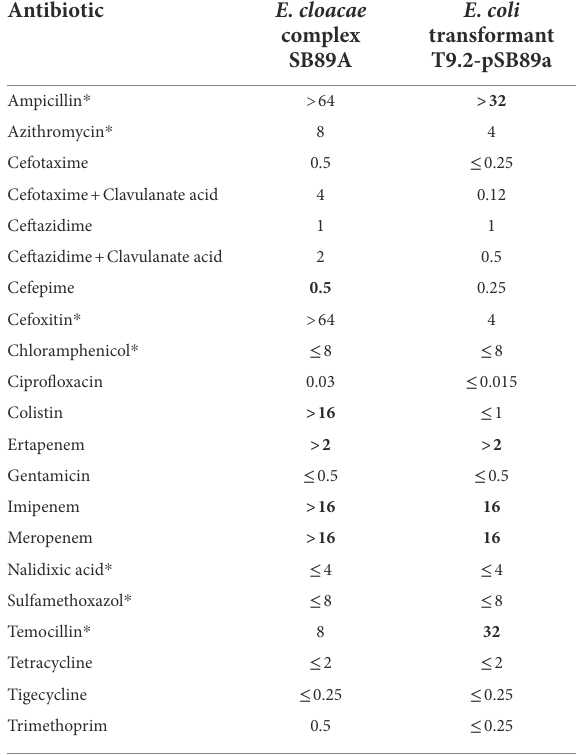
TABLE 2 Antibiotic Minimum inhibitory concentrations (MICs), μg/ml, for the E. cloacae complex SB89A isolate using Sensititre ™ EUVSEC and EUVSEC2 panels and E. coli transformant T9.2-pSB89a using EUVSEC3 and EUVSEC2 panels. Bold MIC indicates MIC above ECOFF for E. cloace or E.